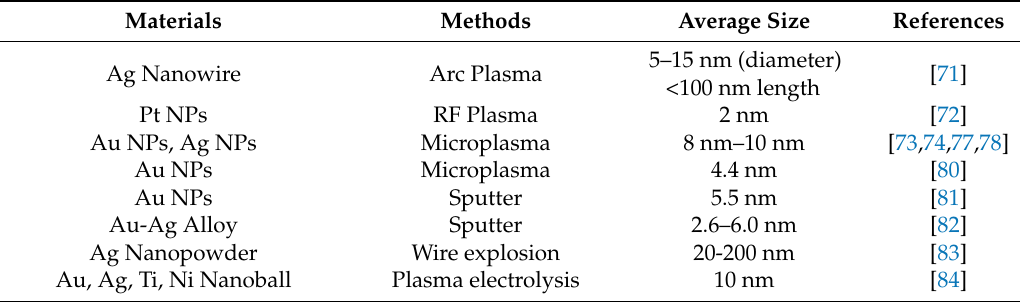
Table 2. Summary of nanomaterials synthesized by plasma